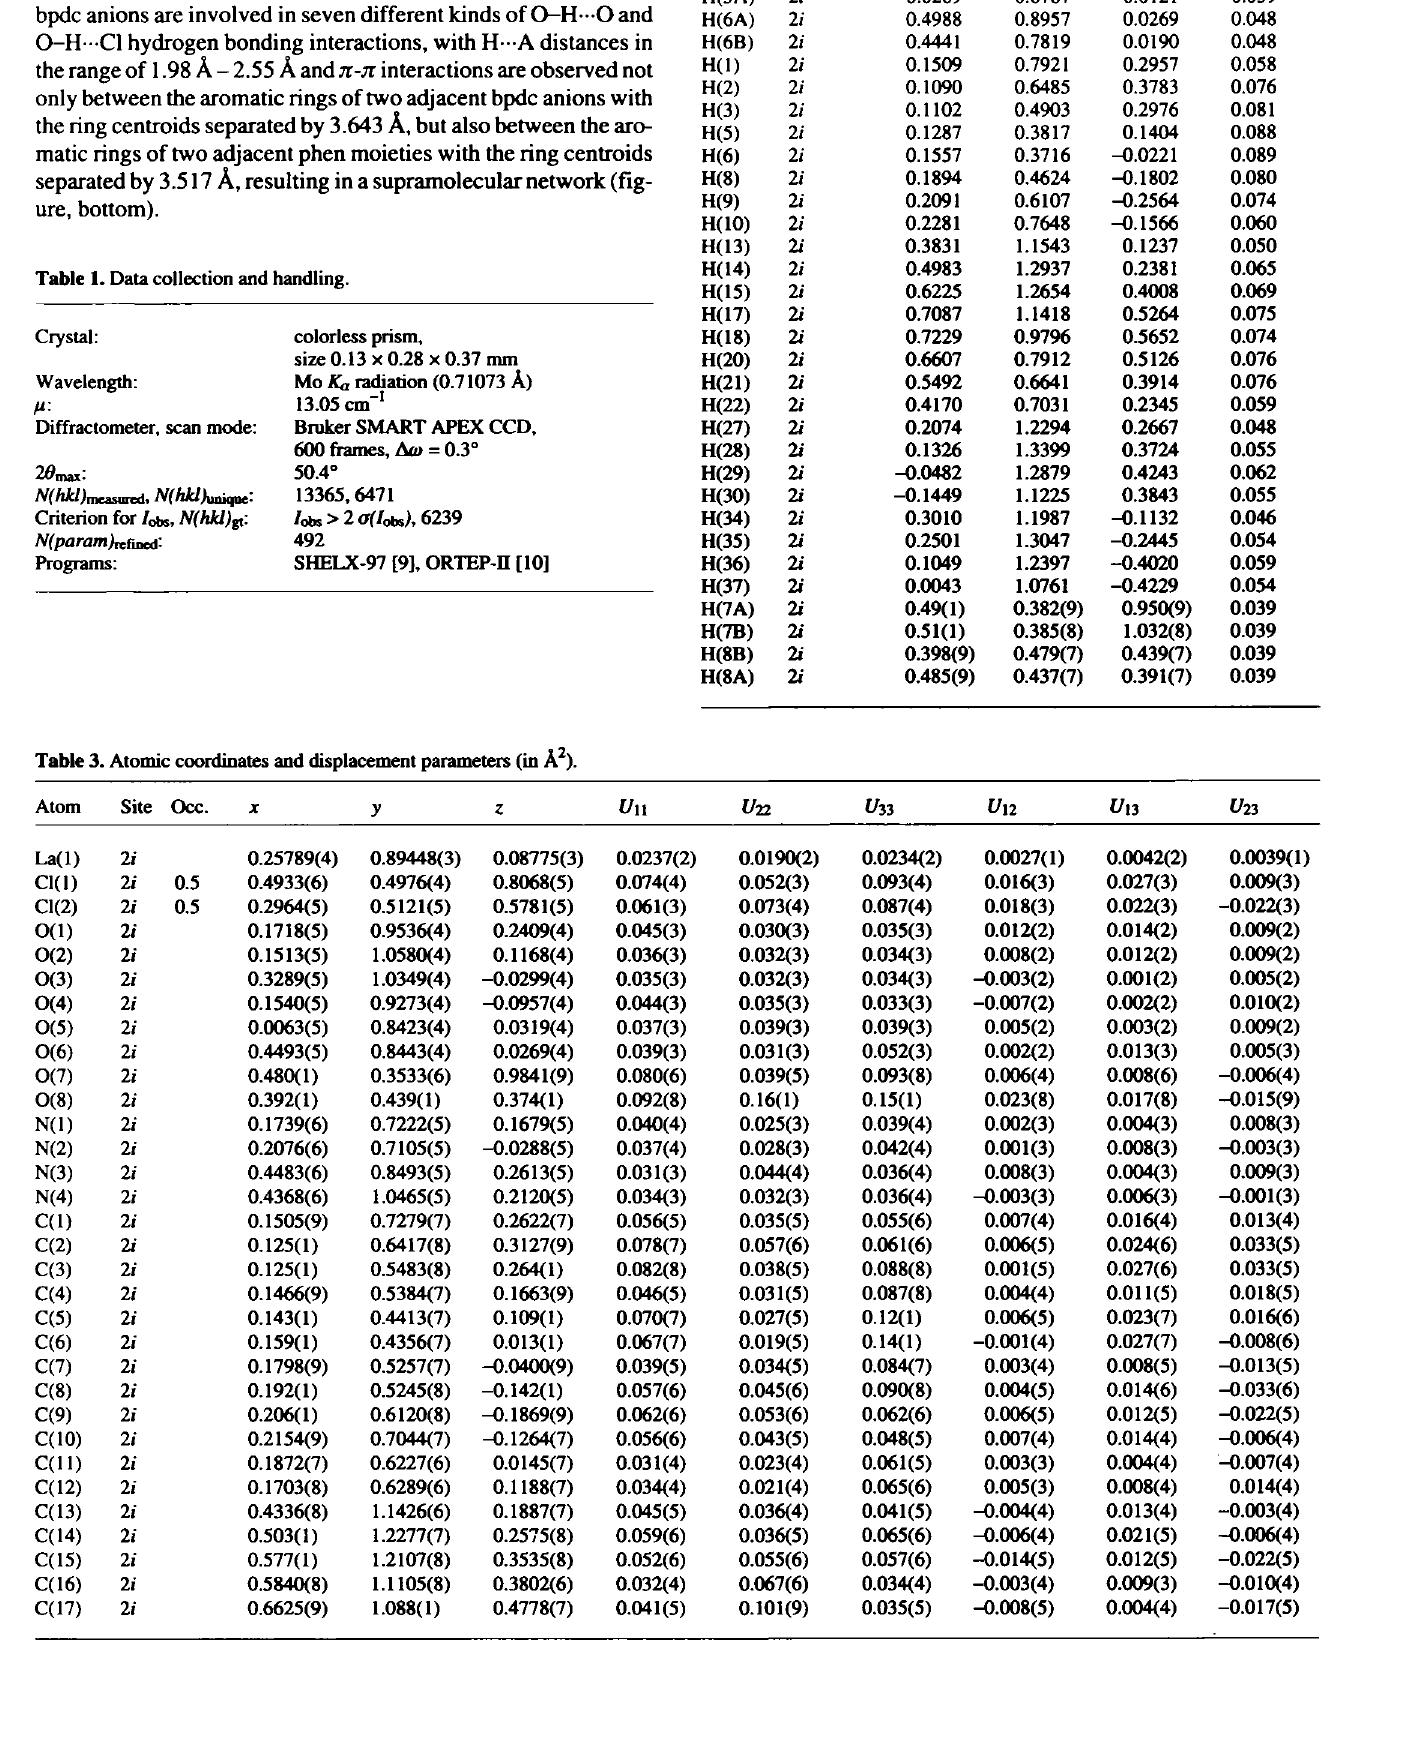
Table 1. Data collection and handling.